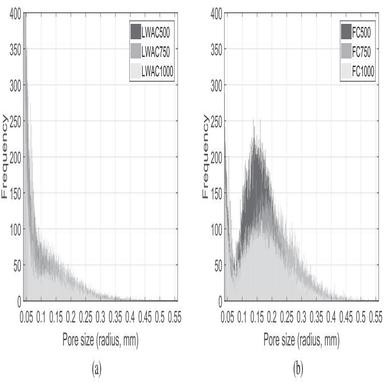
Pore size distribution of LWC specimens: (a) LWAC specimens, (b) FC specimens.